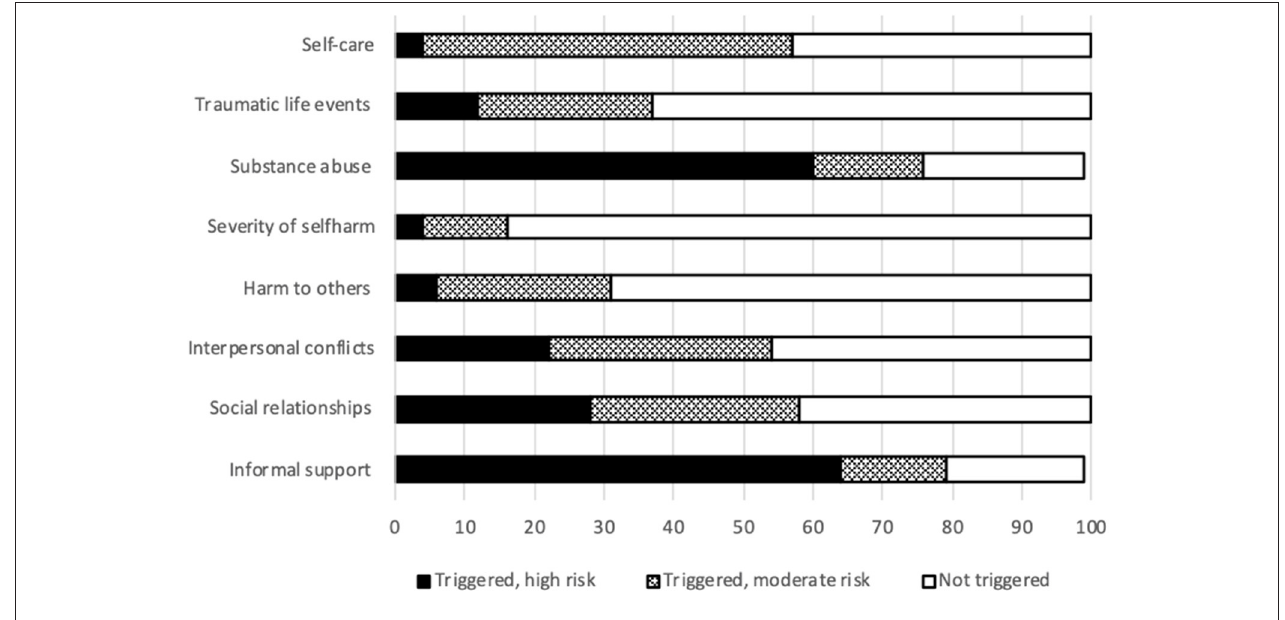
FIGURE 5 | Triggering rates for eight safety